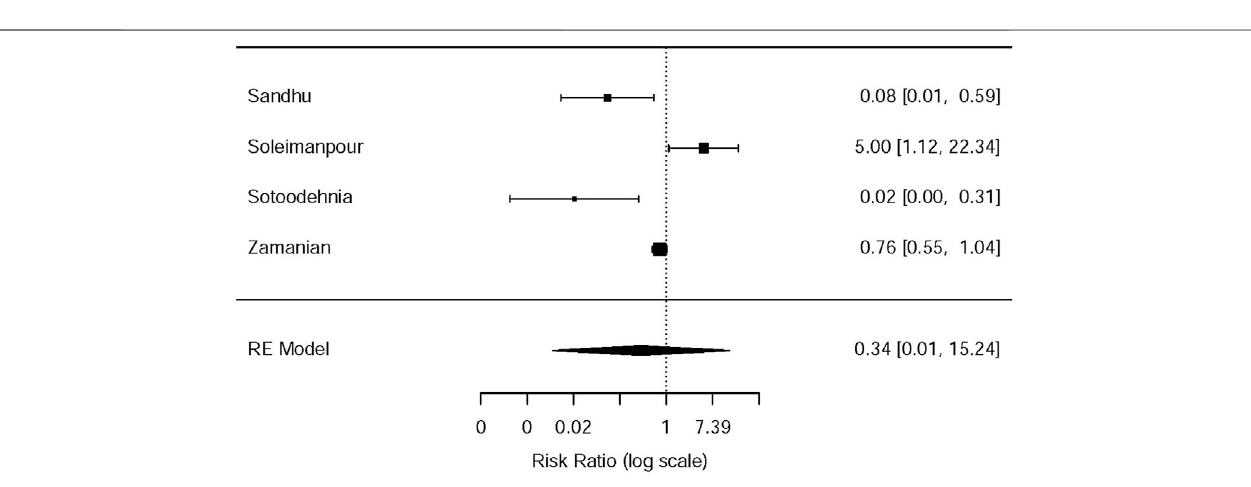
Frontiers in Pharmacology |